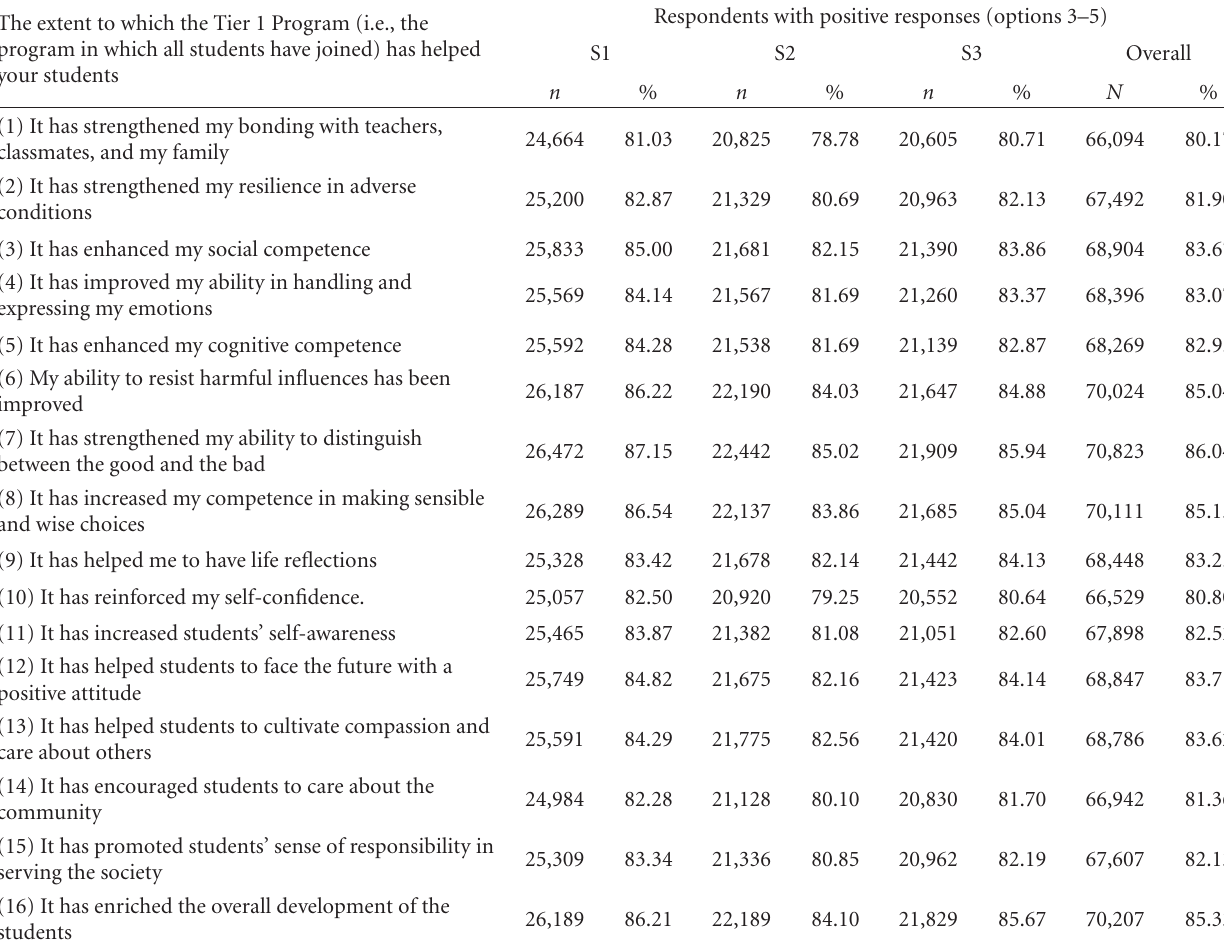
Table 3: Summary of the program participants’ perception toward the program e ff